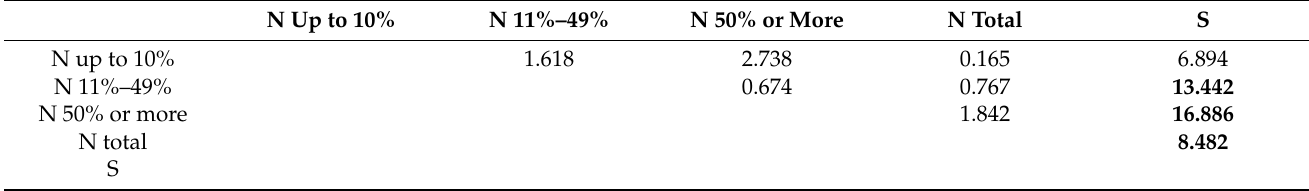
Table 4. Chi-square test results were conducted in order to verify the significance of the differences between the percentage distributions of the surface area of the most important groups of potential natural vegetation (in the area covered by the study) and the number (N) of fir localities (total and broken down into a different share in the stand). Three degrees of freedom. N Up to 10% N 11%–49% N 50% or More N Total S N up to 10%